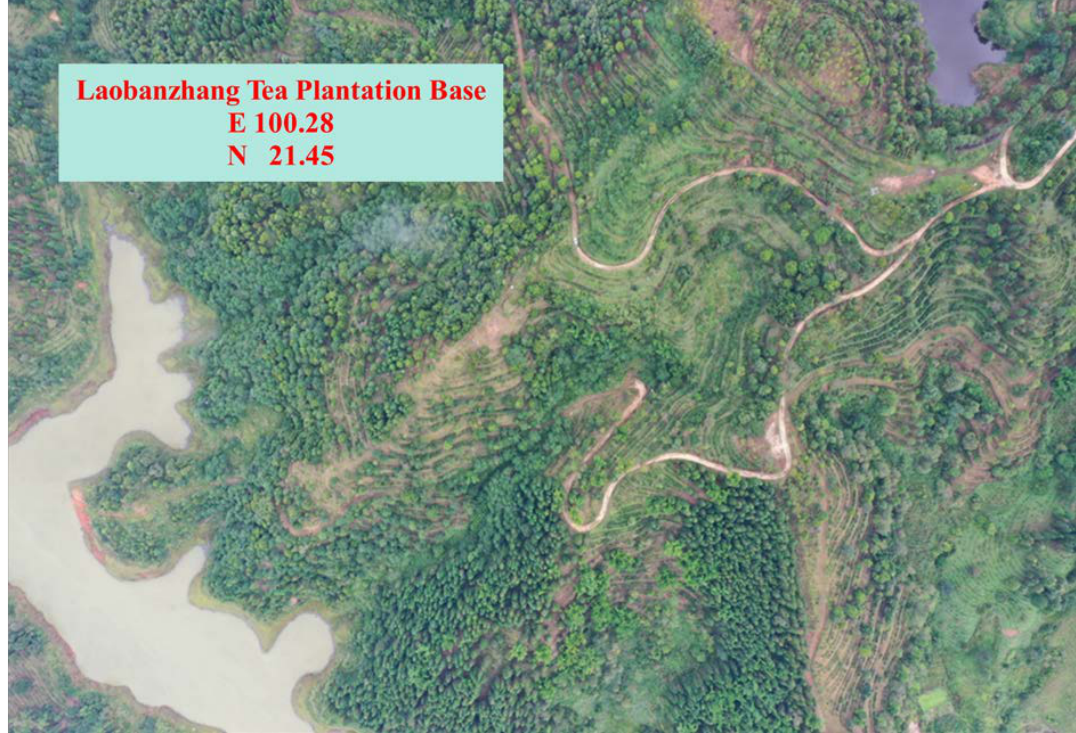
Figure 1. Data acquisition location.